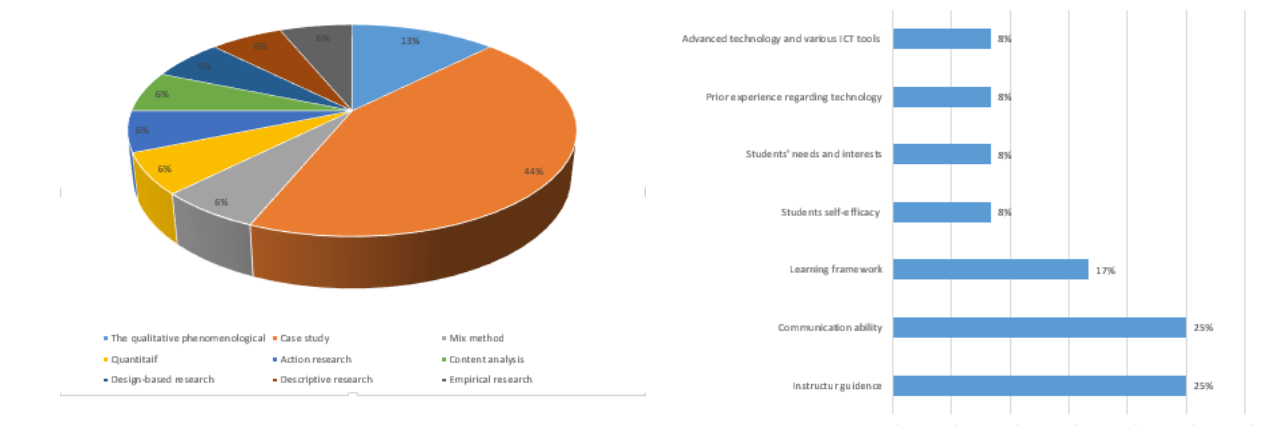
Figure 3: Method of the studies